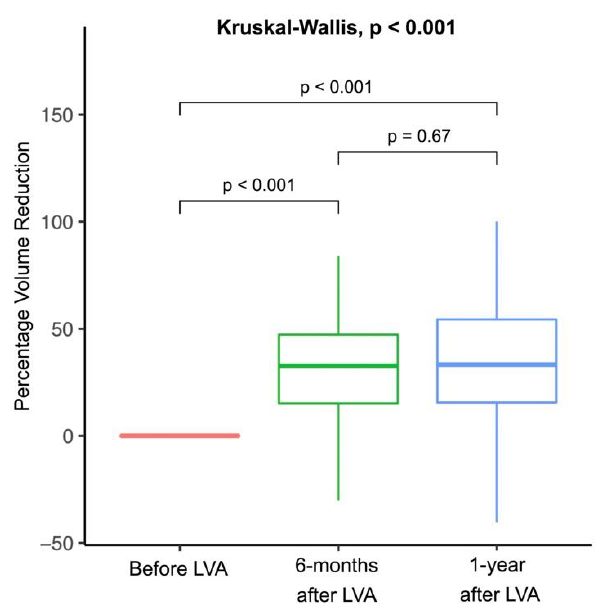
Figure 2. Percentage volume reduction in the lymphedematous limb following lymphaticovenous anastomosis (LVA) showing significant volume reduction at postoperative six months and one year when compared to the pre-LVA volume (both p < 0.001), but without significant difference between postsurgical six months and one year ( p = 0.67). Table 3. Volume reduction after lymphaticovenous anastomosis.